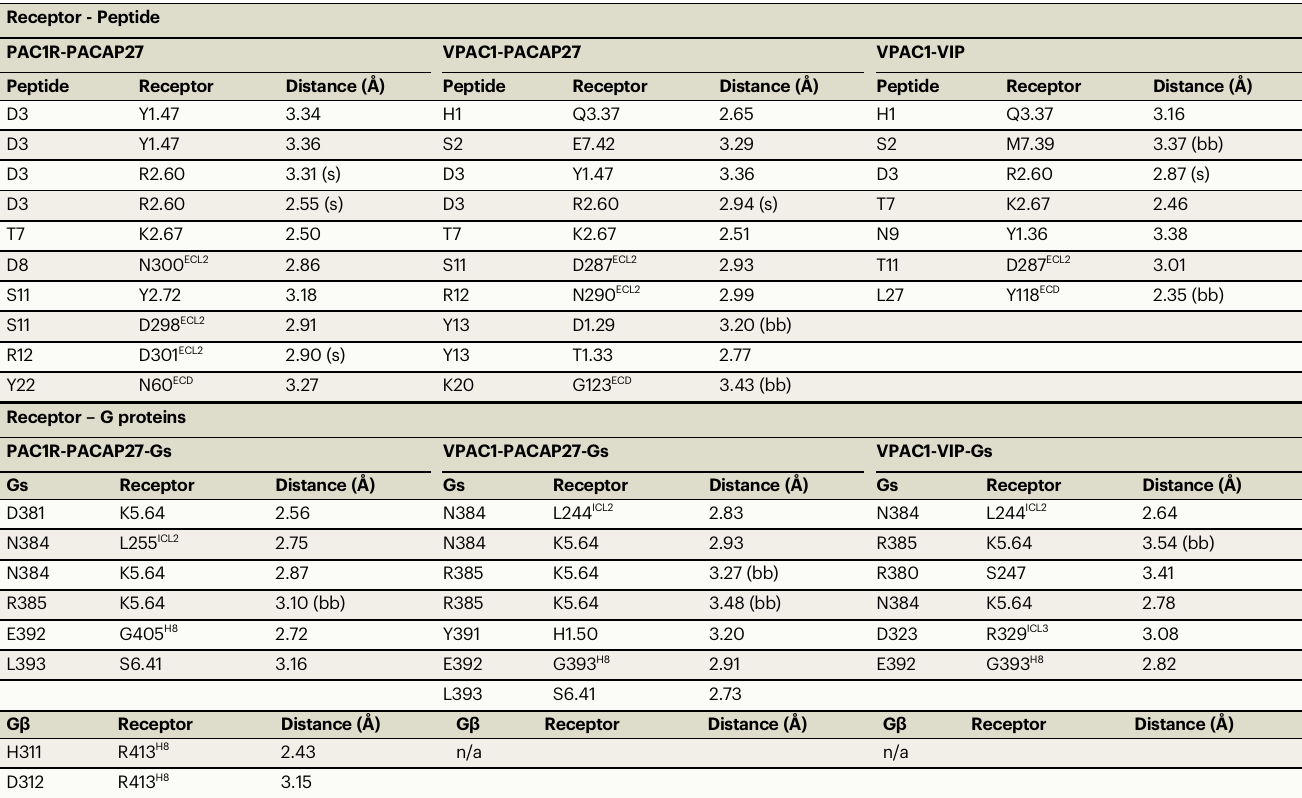
Table 2 | Hydrogen bonds predicted by ChimeraX between receptor and peptide chains and receptor and G protein chains Receptor -